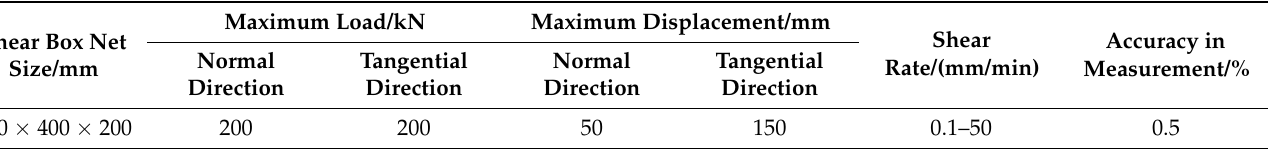
Figure 1. The large direct shear device in Tongji University (SJW-200). Table 1. Major specialized indicators of the large direct shear experiment equipment. The device was composed of three main components: measuring and controlling component, a hydraulic servo component, and loading actuators in the loading component. The major technical indicators were shown in Table 1. The inner sizes of the shear box at the bottom is 600 mm × 400 mm × 100 mm as is the shear box at the top. During the shearing, the shear box at the top which is full of sand is fixed, and the shear box at the bottom which is filled up with concrete is able to move horizontally by a horizontal loading actuator to simulate pile movement through the soil. In order to look into the shear deformation of the soil layers, a window made of plexiglass was provided in the middle of the lower and upper shear box. Hydraulic actuators were adopted to apply horizontal and vertical displacement loads. Two load cells were used to measure the shear stress and vertical stress during shearing. Two linear variable different transformers (LVDTs) were adopted to monitor horizontal and vertical displacement. A computerized data logging system was used to collect all recorded data at 0.4 seconds intervals.